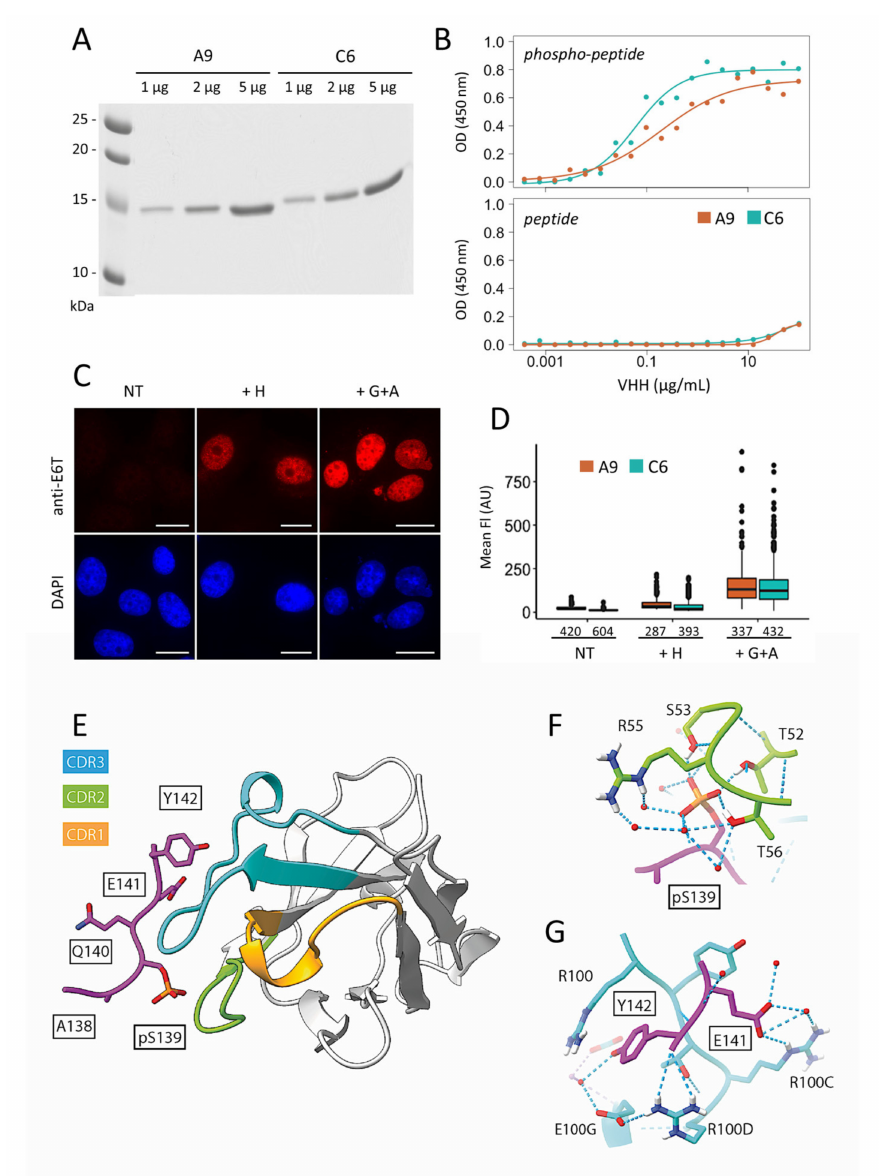
Figure 2. Biochemical and structural analysis of the selected nanobodies. ( A ) SDS-PAGE anal- ysis of the purified nanobodies A9 and C6. ( B ) The binding capacity of the purified samples shown in ( A ) was tested by ELISA with either phosphorylated (phosphopeptide; 1 µ g/mL) or non-phosphorylated (peptide; 1 µ g/mL) C-terminal H2AX peptide coated on plate. ( C ) Im- munofluorescence assay with C6 nanobody. H1299 cells were treated for 24 h with the indicated drugs (H, hydroxyurea; G+A, gemcitabine + AZD-7762) and incubated after fixation with nanobody C6. Bound molecules were revealed with anti-tag E6 antibodies (anti-E6T) and Alexa 568-labelled anti-mouse IgG. The nuclei were counterstained with DAPI (blue). Scale bar: 20 µ m. NT, untreated cells. ( D ) Quantification of the γ -H2AX fluorescence signal recorded following incubation of the cells treated as in ( C ) with either A9 or C6 nanobody. ( E ) Crystallographic 3D-structure of the C6 nanobody in complex with the phosphorylated peptide corresponding to γ -H2AX C-terminal tail (ApSQEY). The CDR1, CDR2, and CDR3 loops colored in yellow, green, and blue, respectively. The γ -H2AX tail is shown in magenta and peptide residues are boxed. ( F , G ) Close-up view of the γ -H2AX tail peptide in the nanobody binding site. Residues are color coded and labelled as in ( E ). Water molecules in the interface between the γ -H2AX tail and the nanobody are represented as red spheres and hydrogen bonds are represented as blue dotted